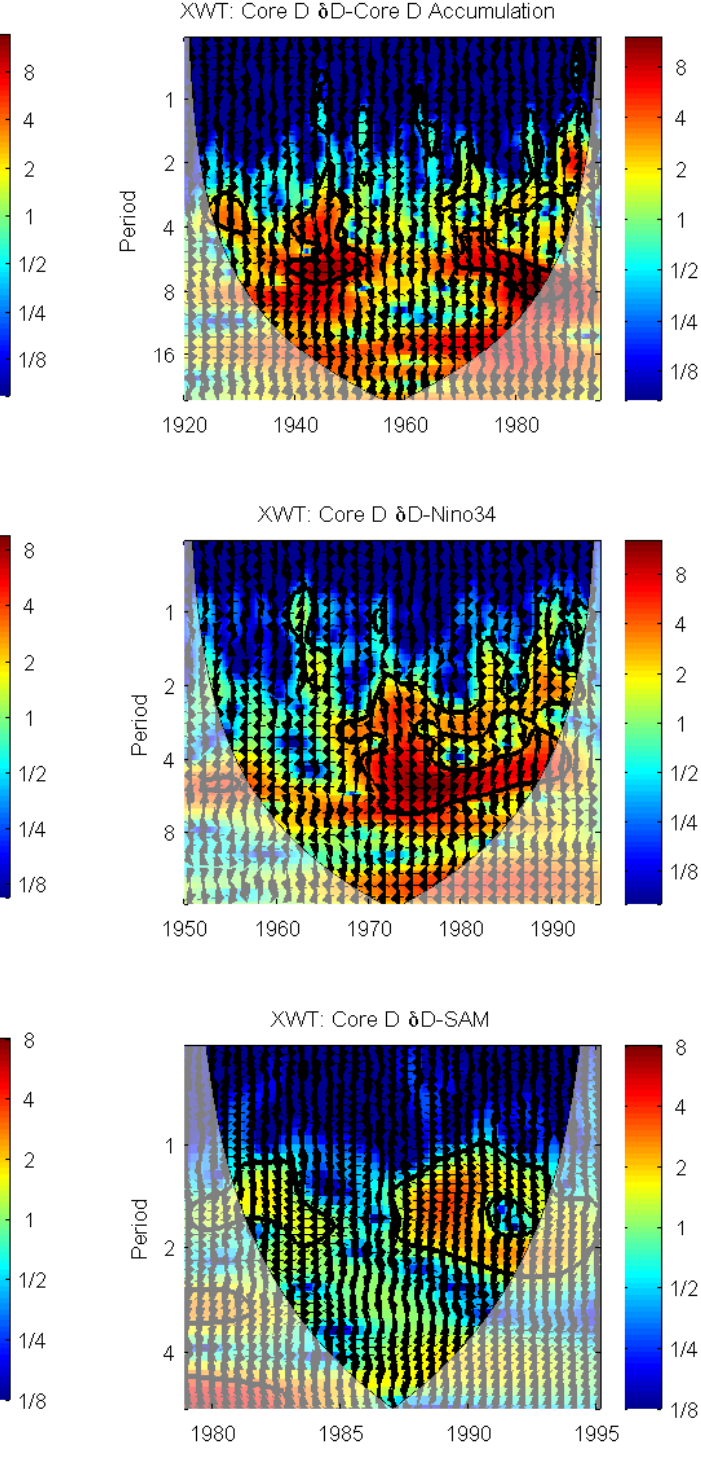
Figure A2. Top panel: core G δ D and core G net accumulation XWT from 1657 to 1995. Middle panel: core G δ D and Niño 3.4 XWT from 1950 to 1995. Bottom panel: core G δ D and SAM XWT from 1979 to 1995.